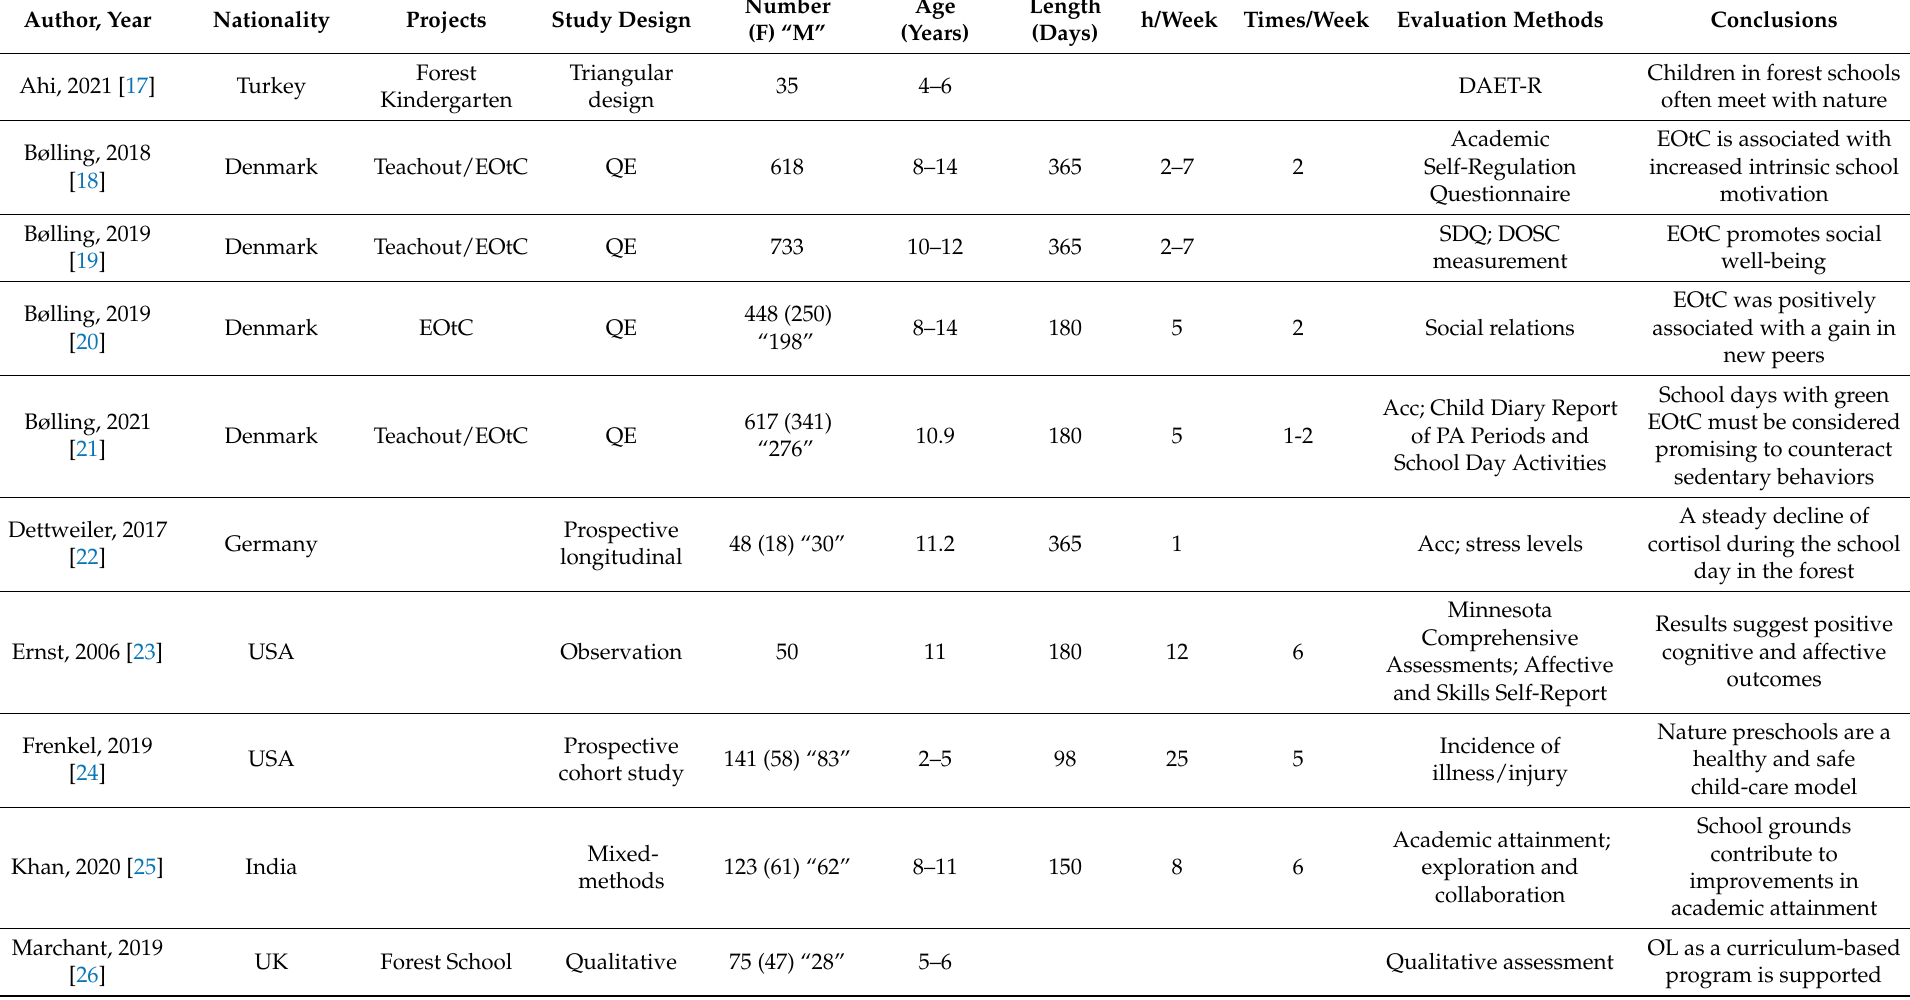
Table 1. Characteristics of the included